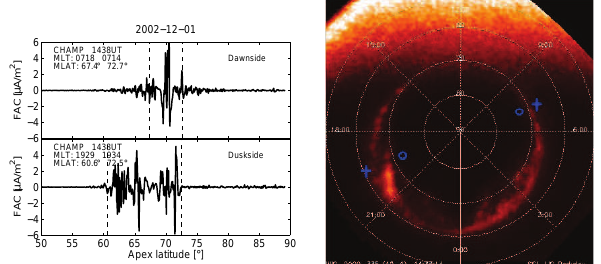
Figure 11. (left) CHAMP FAC observations in the Northern Hemi- sphere at 14:38 UT both at dawn- (top) and duskside (bottom) on Fig. 11. (left) CHAMP FAC observations in the northern hemisphere at 14:38 UT both at dawn (top) and 1 December 2002. The boundaries of the auroral oval have been duskside (bottom) on December 1, 2002. The boundaries of the auroral oval have been marked with dashed marked with dashed lines. (right) Simultaneous observation of the lines. (right) Simultaneous observation of the auroral oval in the northern hemisphere from IMAGE FUV-WIC auroral oval in the Northern Hemisphere from IMAGE FUV-WIC observations at 14:37:11 UT, the blue crosses and circles are the boundaries determined from CHAMP FAC observations at 14:37:11UT; the blue crosses and circles are the observations. boundaries determined from CHAMP FAC